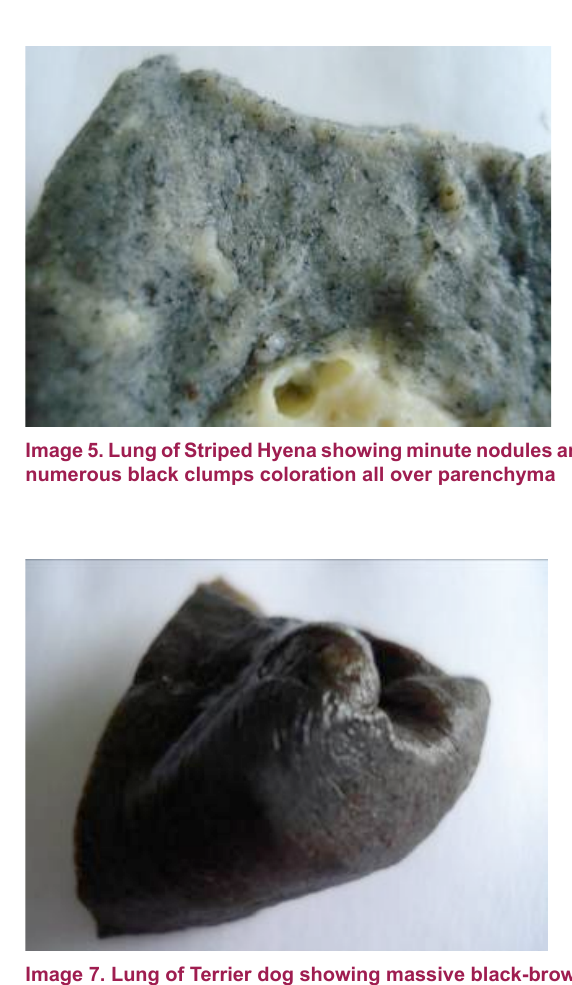
Image 8. Lung of Zebra showing caseous nodules and black-brown coloration all over the parenchyma